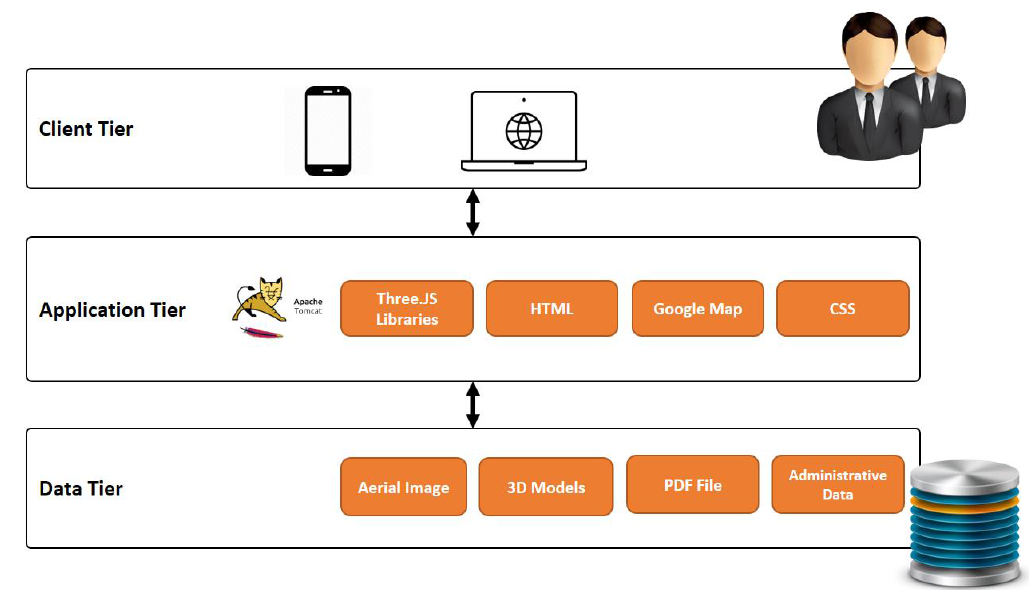
Figure 3. The proposed architecture for the development of the prototype.